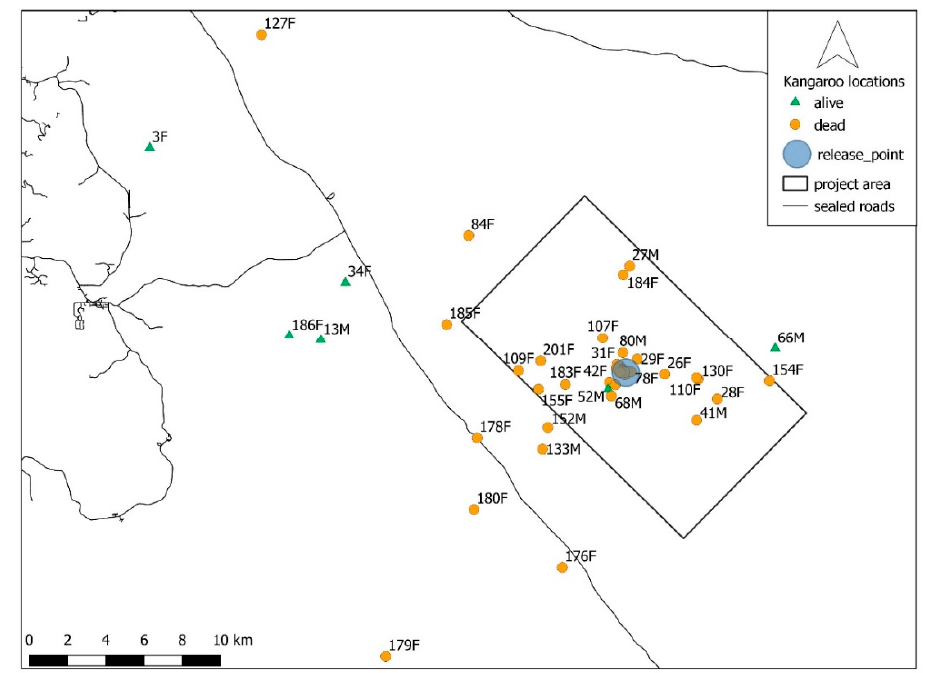
Figure 3. Maximum distance moved by relocated western grey kangaroos from the release site. Triangles represent those animals surviving for the duration of the study. Circles represent those animals that died.